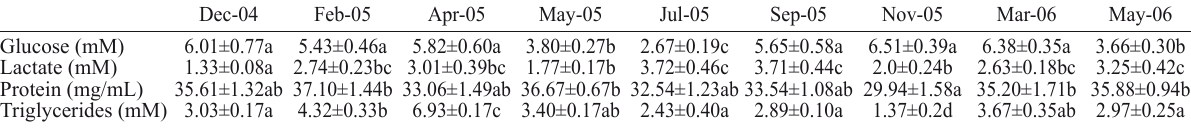
Table 3. – Seasonal changes in plasmatic metabolite levels in A. regius specimens cultured in earthen ponds. Further details as in legend of Figure 2.